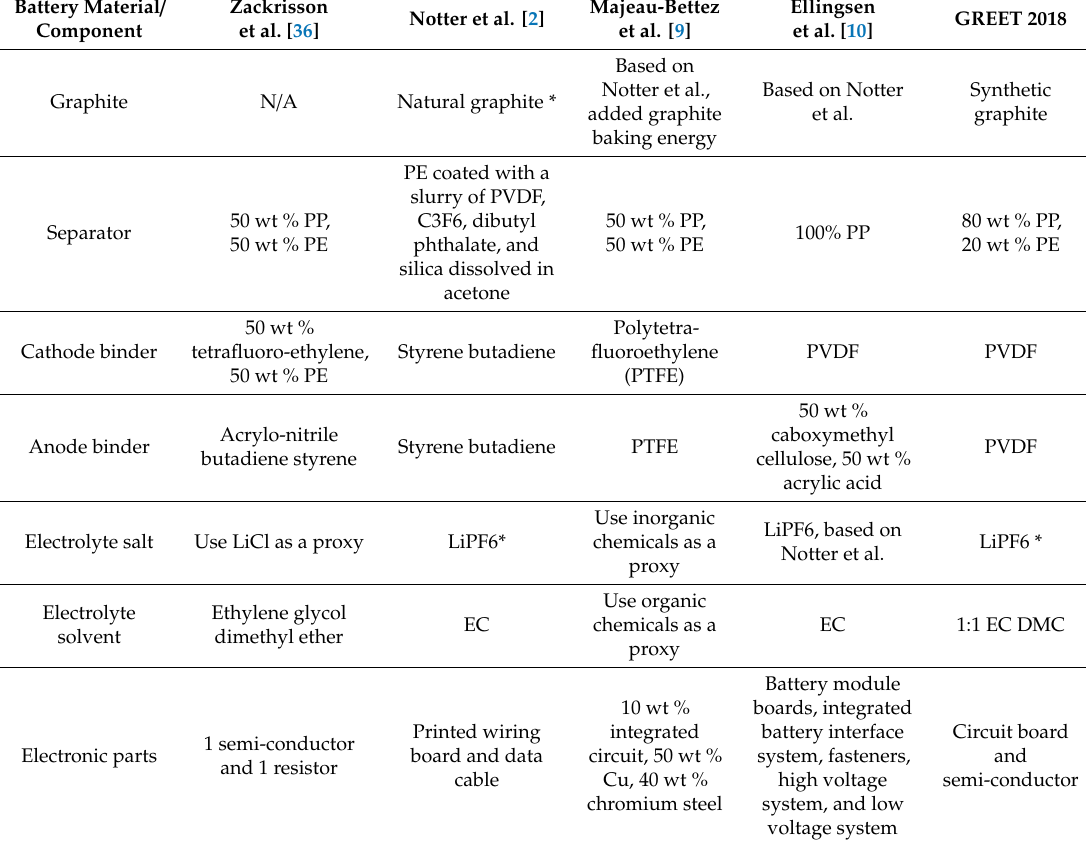
Table 1. Summary of assumptions made for key battery materials in existing lithium-ion battery (LIB) life cycle analysis (LCA)